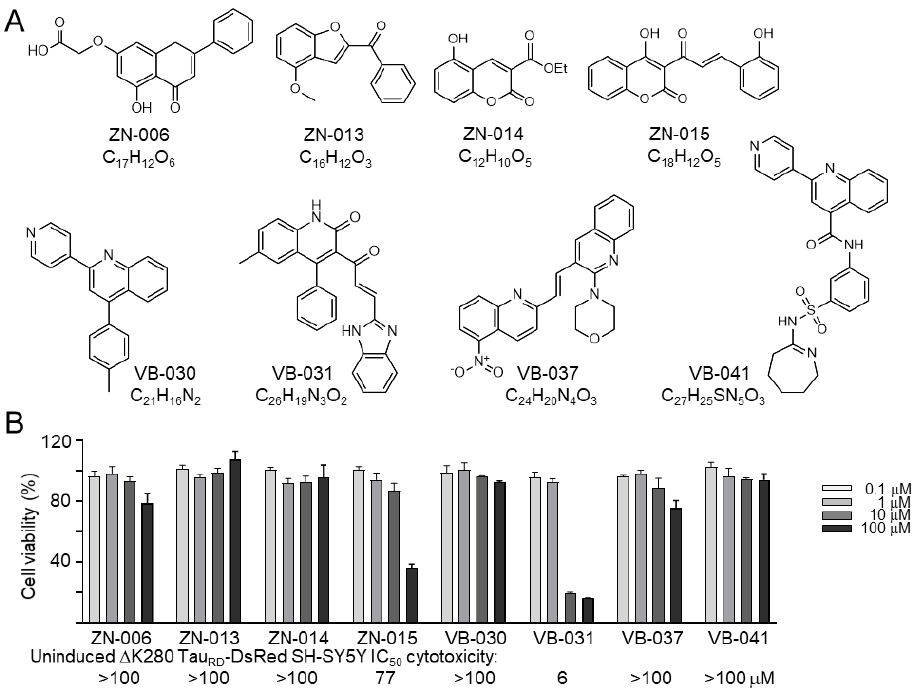
Figure 1. Test compounds. ( A ) Structure and formula of ZN-006, -013, -014, -015, and VB-030, -031, -037, -041. ( B ) MTT cell viability assay of ZN/VB compounds in ∆ K280 Tau RD -DsRed SH-SY5Y cells, with test compounds (0.1–100 µ M) treated for 24 h ( n = 3). The viability of untreated cells was set at 100% for normalization. Calculated IC 50 values are shown